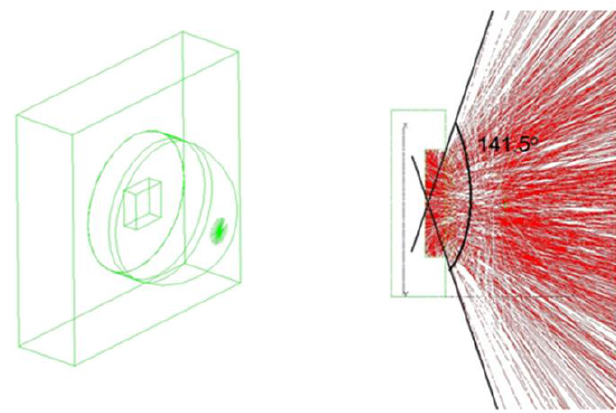
Figure 3. LED scattering angle in simulation. Table 2. LED optical characteristics.